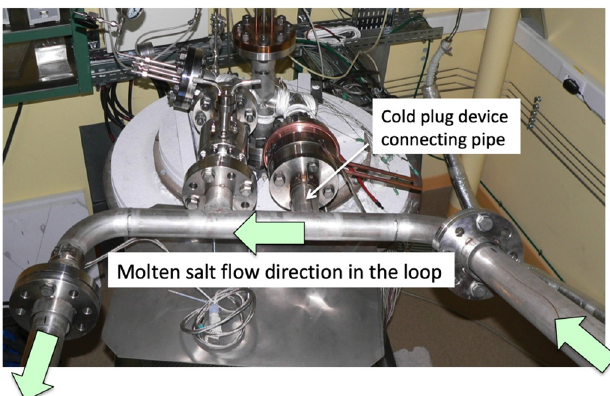
Fig. 7. Final assembly of the twofold valve system between the tank and the loop. The photograph has been taken before the whole insulation implementation.